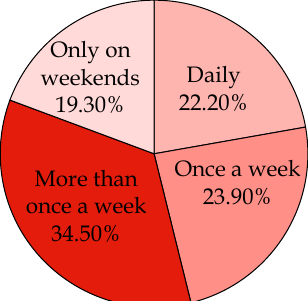
Figure 9. Responses on the frequency of visits of the UGAs before the beginning (March 2020) of COVID-19 restrictions (research question: “How often did you visit the UGAs of your municipality, before the beginning (March 2020) of the COVID-19 restrictions?”).